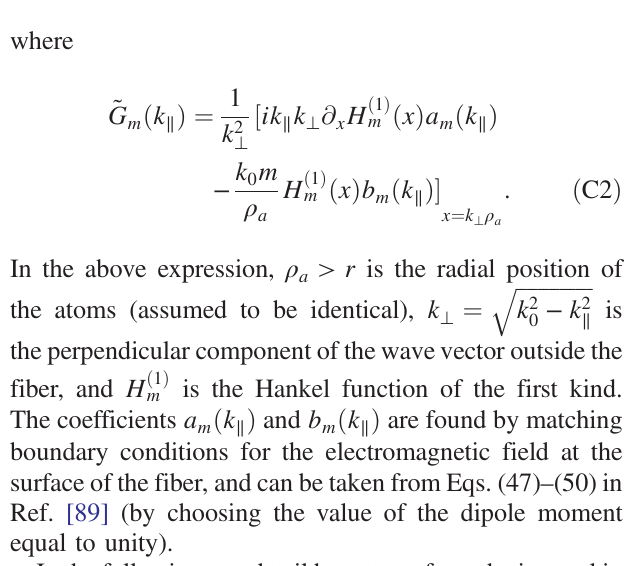
FIG. 20. Integration contour for Eq. (C1) depicting the pole and branch